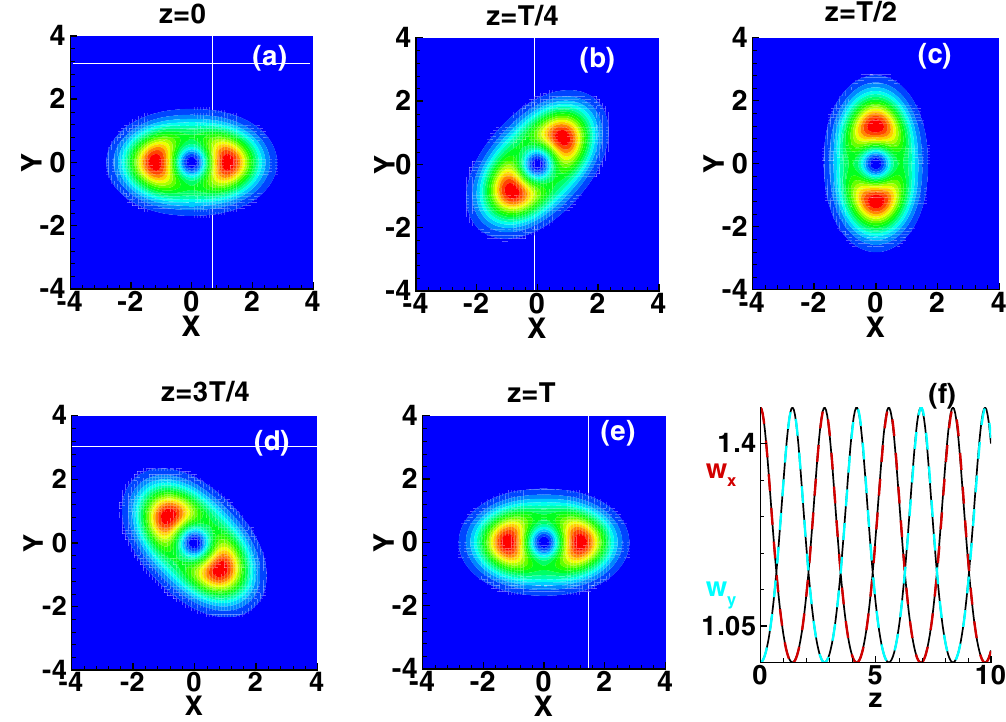
Figure 2. Evolution of the first-order mode of the spiraling elliptic Hermite-Gaussian solitons. Profiles are plotted at different propagation distances: ( a ) z = 0, ( b ) z = T /4, ( c ) z = T /2, ( d ) z = 3 T /4, and ( e ) z = T ( = 2.78). The beam width w x and w y in the x and y directions are plotted in ( f ), where solid black lines and dashed color lines denote the variational solution and numerical simulations respectively. The parameters are b = 1.2, c = 0.8, and w m =